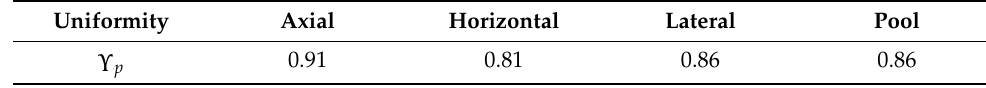
Table 2. Summary and comparison of distribution uniformity.